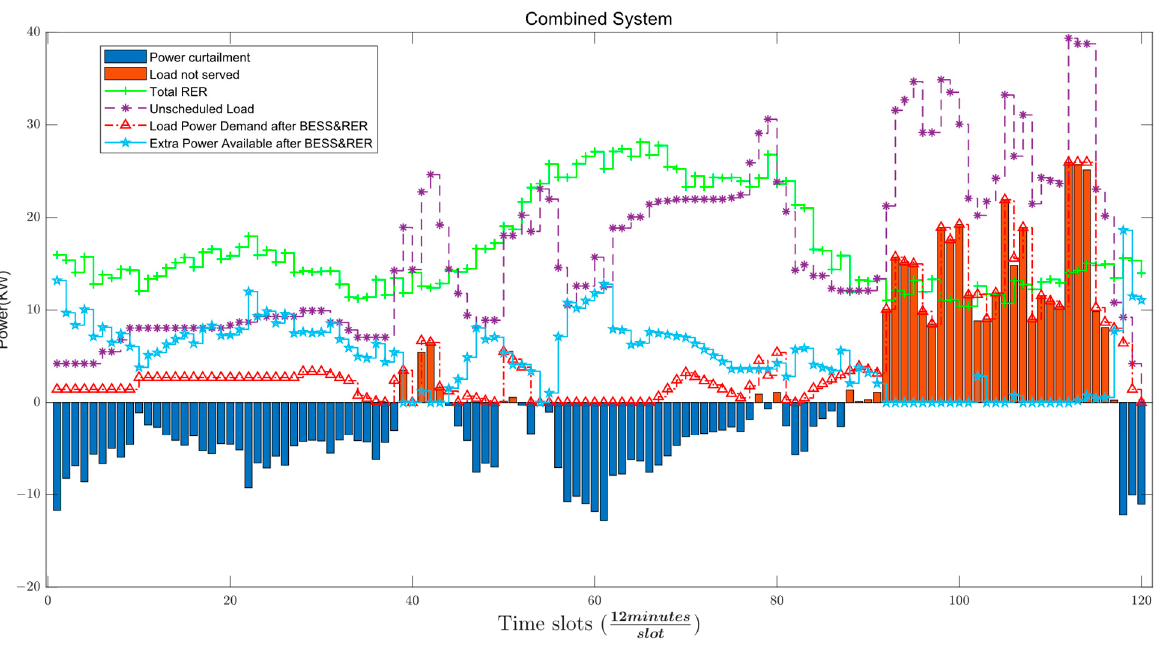
Figure 14. Energy management system for unscheduled load.